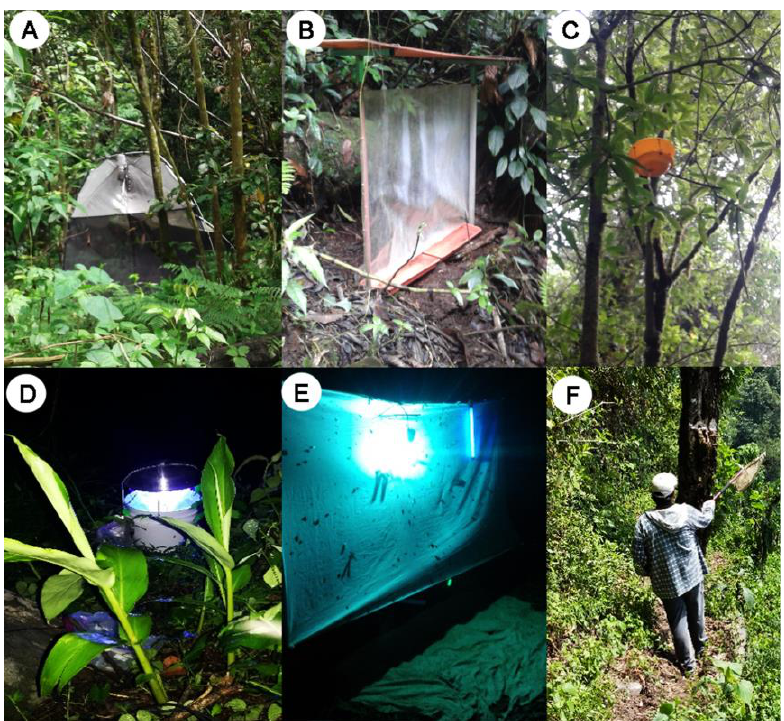
Figure 2. Different types of sampling methods implemented in this study. ( A ) Malaise trap; ( B ) Ground-level interception traps; ( C ) Yellow plate traps; ( D ) Black light trap; ( E ) Black and white light trap; ( F ) Entomological net (Reprinted with permission from Cancino et al. [39]. Copyright 2021, by the authors).